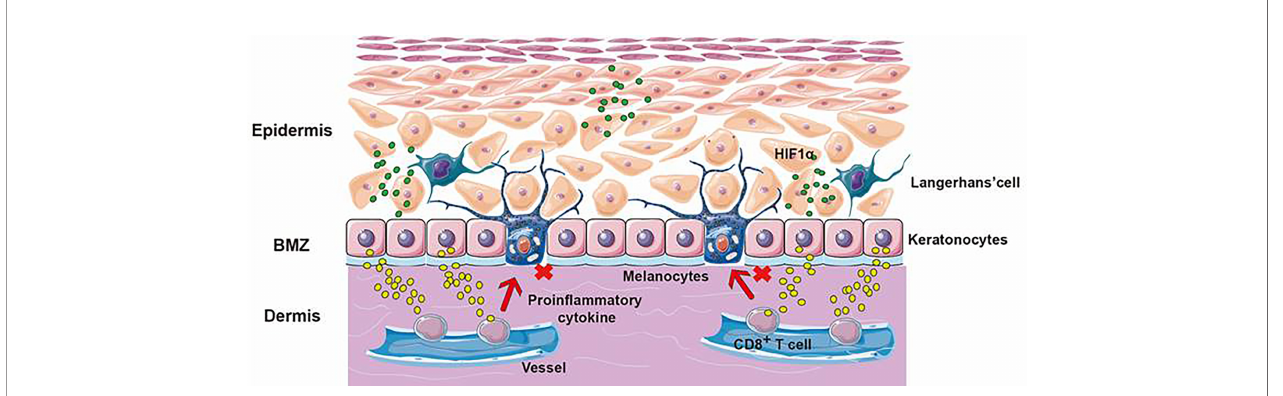
FIGURE 6 | The application of CAP application on vitiligo. The skin is divided into the epidermis, dermis, and subcutaneous tissue layers. Vitiligo results from the targeted destruction of melanocytes. ROS and RNS from CAP could promote the release of HIF-1 a , cause keratinocytes to release cytokines, inhibit the cytotoxicity of CD8 + T cells and avoid the targeted destruction